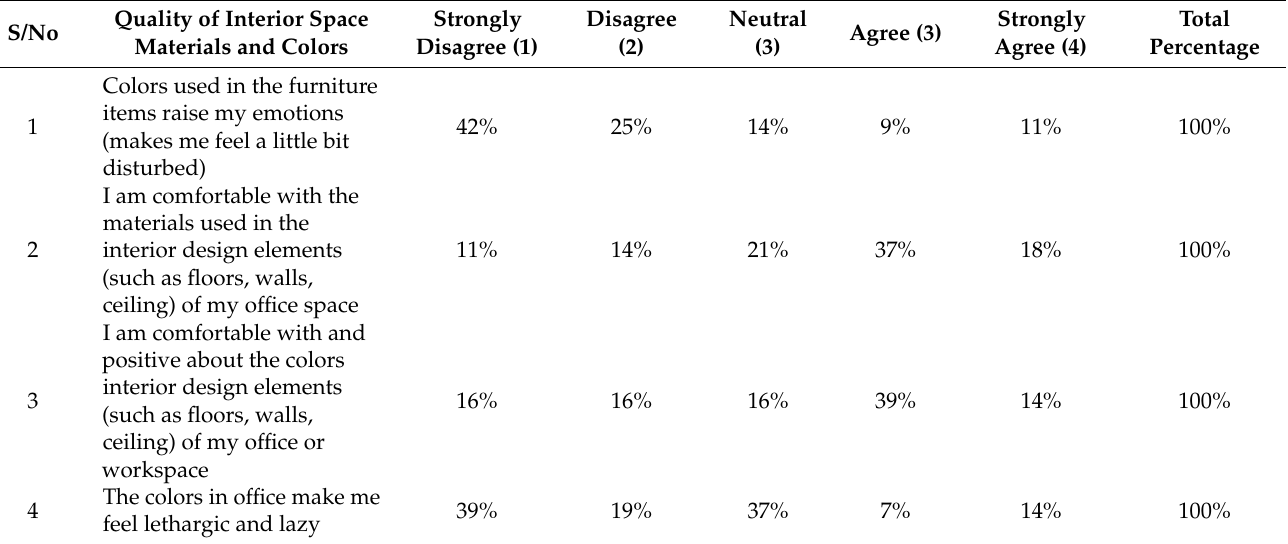
Table 4. Assessment of the quality of interior space materials and